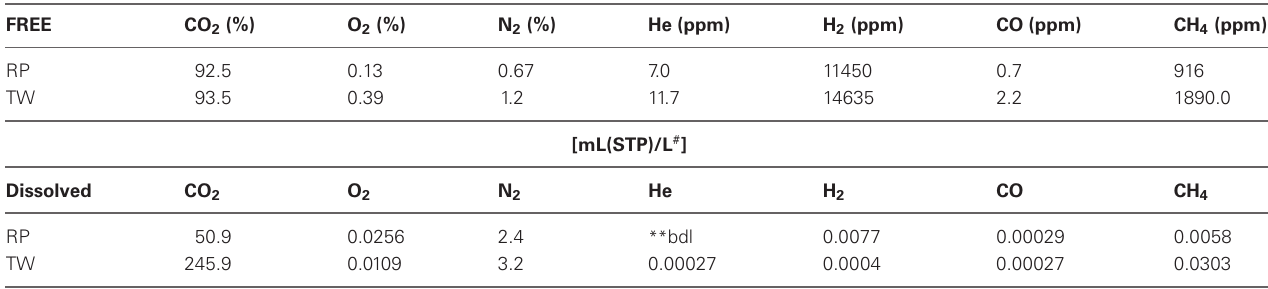
FIGURE 3 | Depth profiles of temperature, pH, chloride and arsenic concentrations at the RP and TW sites. Note (1) similarities between the RP and TW site with respect to T and pH, and (2) differences between these Table 2 | Free and dissolved gas collected for this study ∗